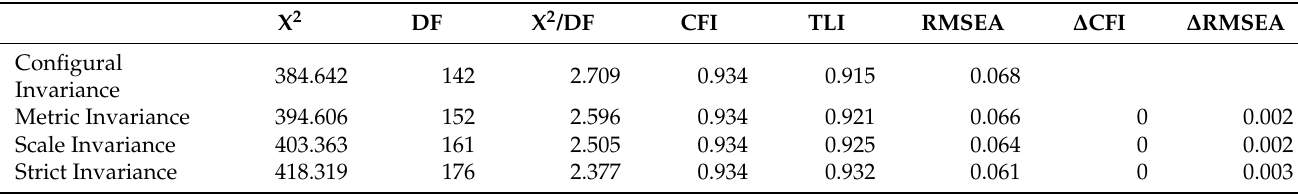
Table 6. Factorial invariance of the model according to